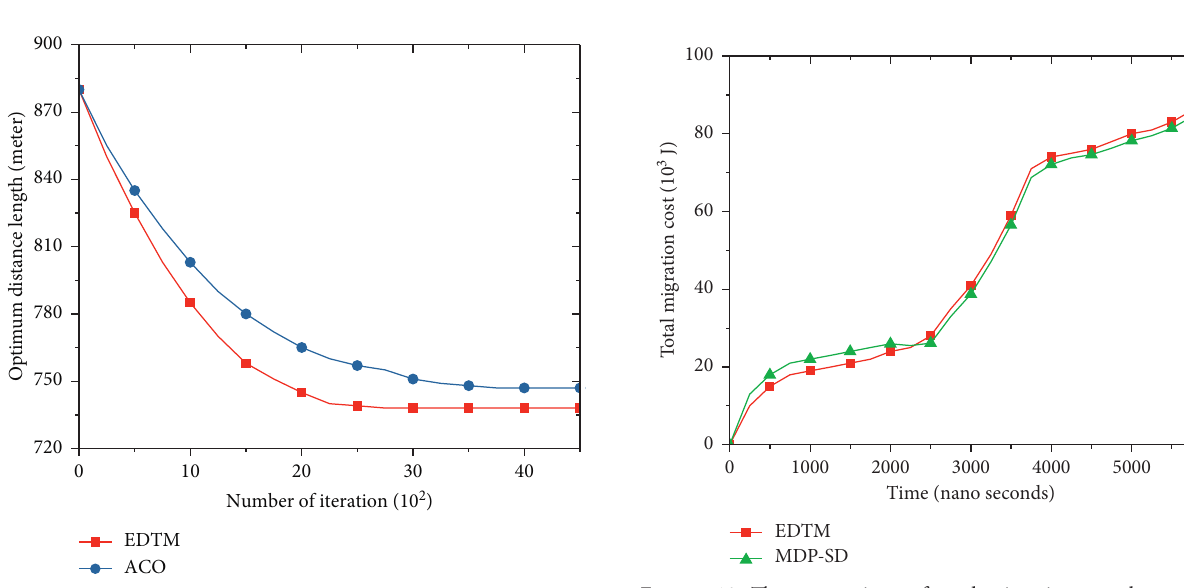
Figure 11: The convergence comparison between the proposed EDTM algorithm and the ACO algorithm.